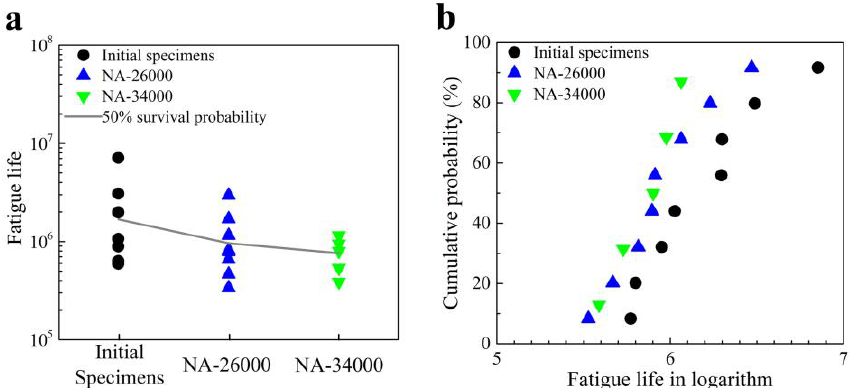
Figure 3. Fatigue life of 25CrMo4 specimens: ( a ) fatigue life versus natural-aging duration, ( b ) cumulative probability of fatigue life in logarithm after different natural-aging durations.